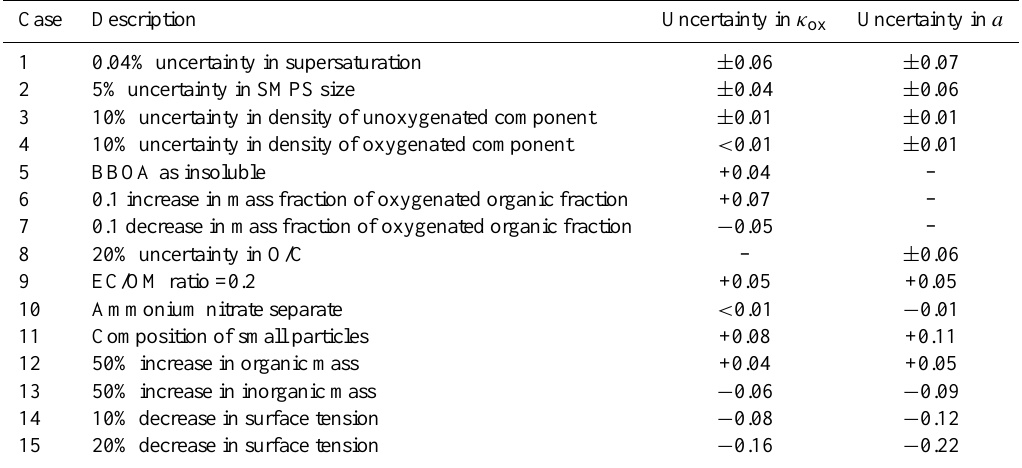
Table 3. Sensitivity analysis for potential uncertainties in the two calculaton methods. See text for description of each